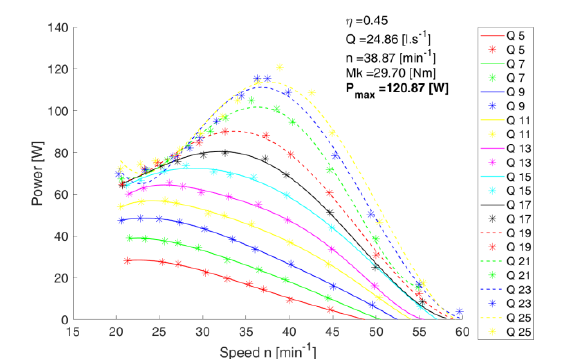
Fig. 10. Output power for configuration, bucket -20 and channel edge position -40 for different flow rates.